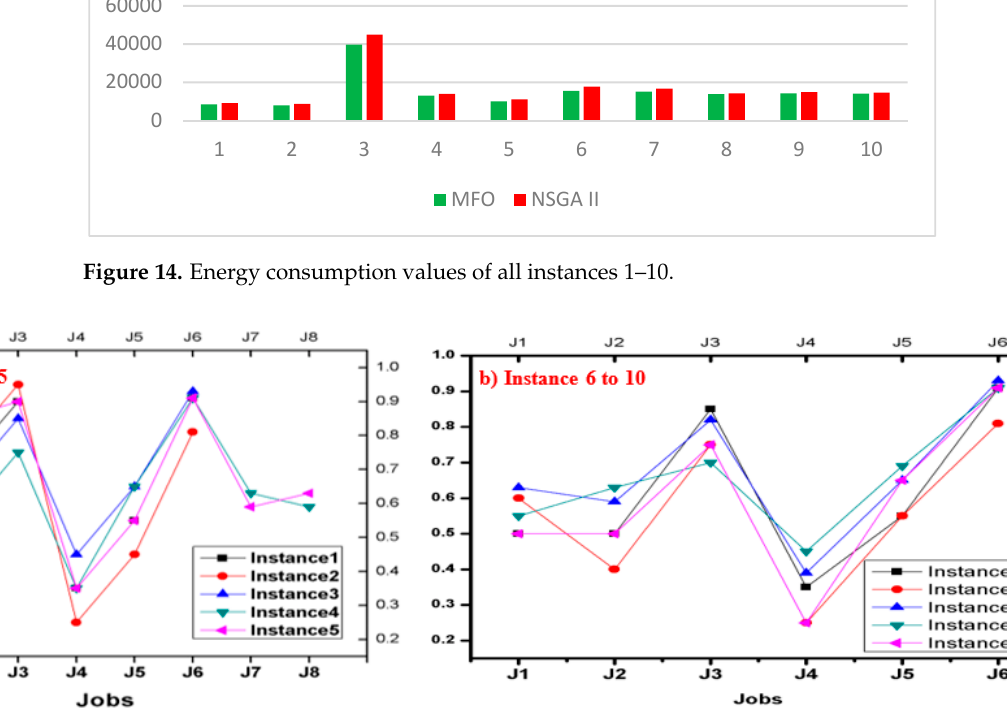
Figure 15. Reliability of different jobs of instance from 6–10.